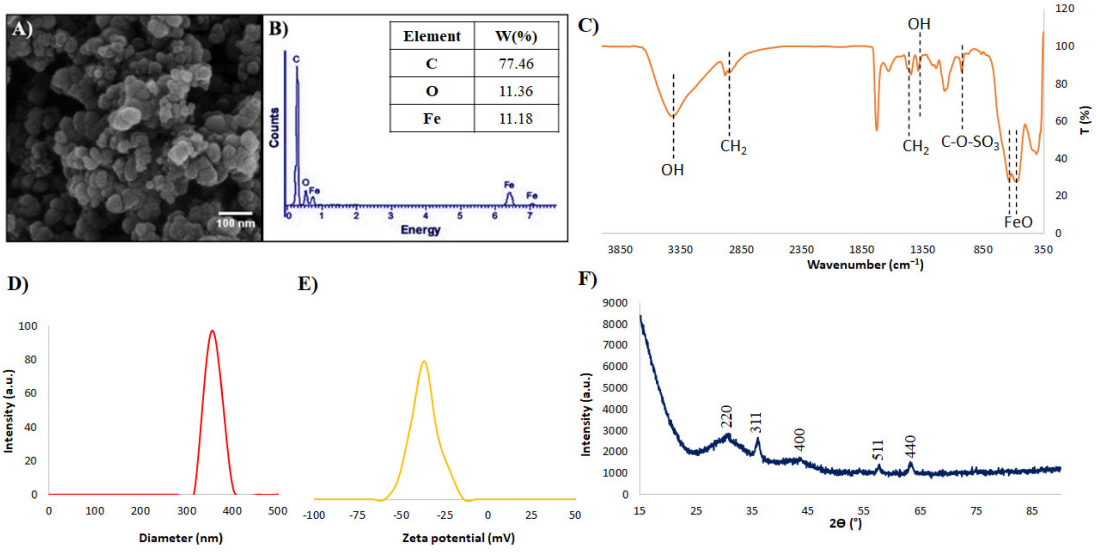
Figure 1. ( A ) SEM image, ( B ) EDX, ( C ) FTIR, ( D ) DLS, ( E ) Zeta, and ( F ) XRD analysis of superparam- agnetic iron oxide nanoparticles coated with dextran sulfate.